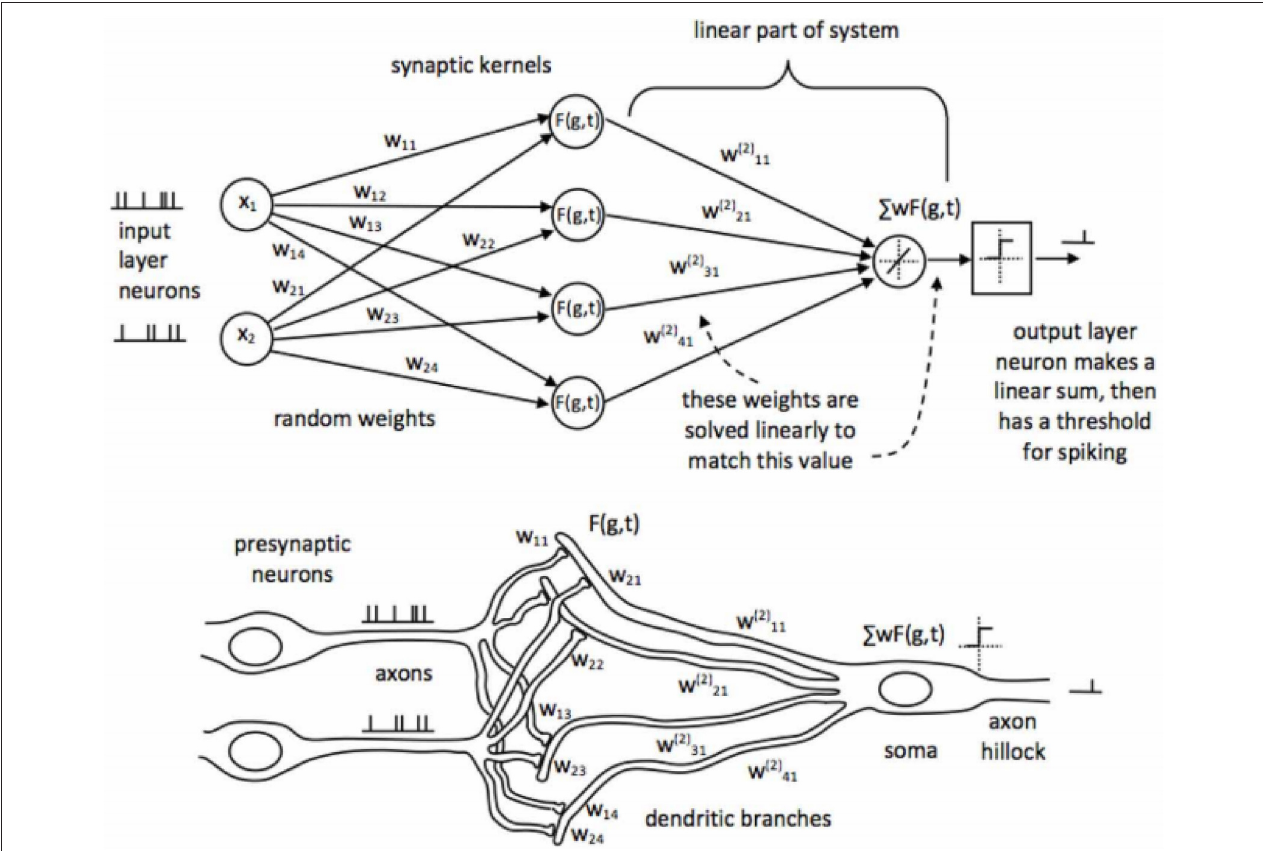
FIGURE 1 | Topology of the Synaptic Kernel Inverse Method (SKIM) as shown in Tapson et al. (2013). Each input layer neuron (left) will be an input from a separate pixel. At initialization, the static random weights and synaptic kernels are randomly assigned and they remain fixed throughout the learning process. During learning, the output weights in the linear part of the system are solved to minimize the error between the system output and the desired